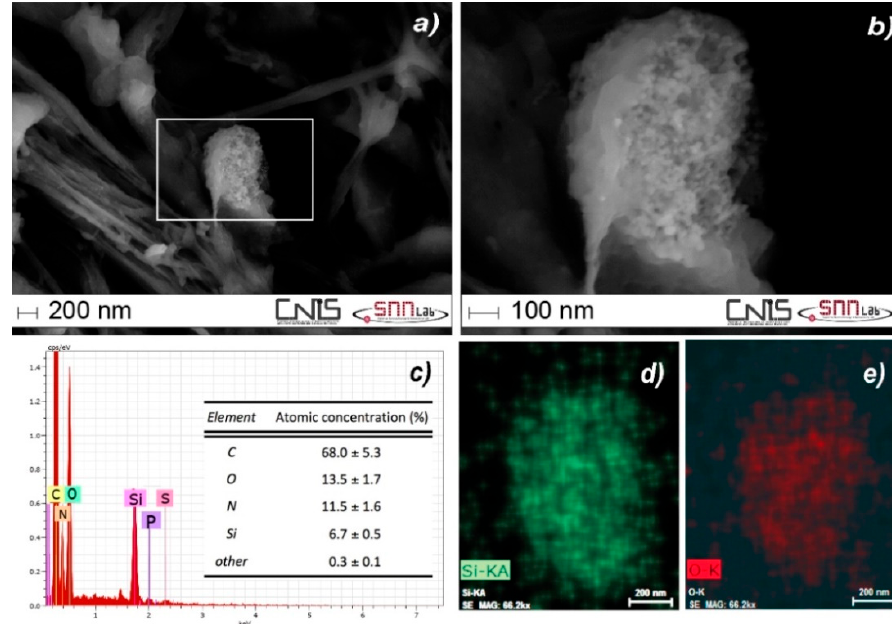
Figure 6. SEM micrograph of a portion of liver tissue from a NM-203 IV-treated animal showing a silica agglomerate at a magnification of 65.00 k × ( a ) and a magnification of 200.00 k × ( b ); ( c ) portion of the EDX spectrum documenting the presence of Si and O, from which the agglomerate is identified as SiO 2 ; compositional EDX maps of Si ( d ) and O ( e ) .